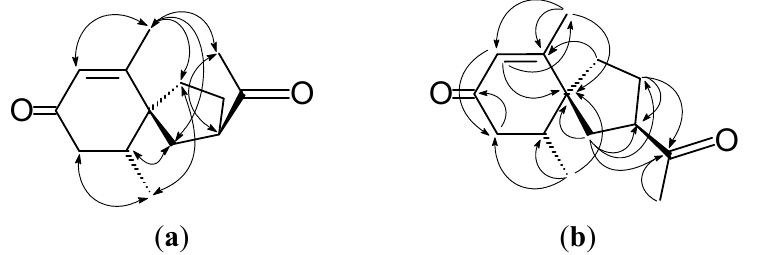
Figure 3. Key NOESY contacts ( a ) and HMBC connectivities ( b ) of compound